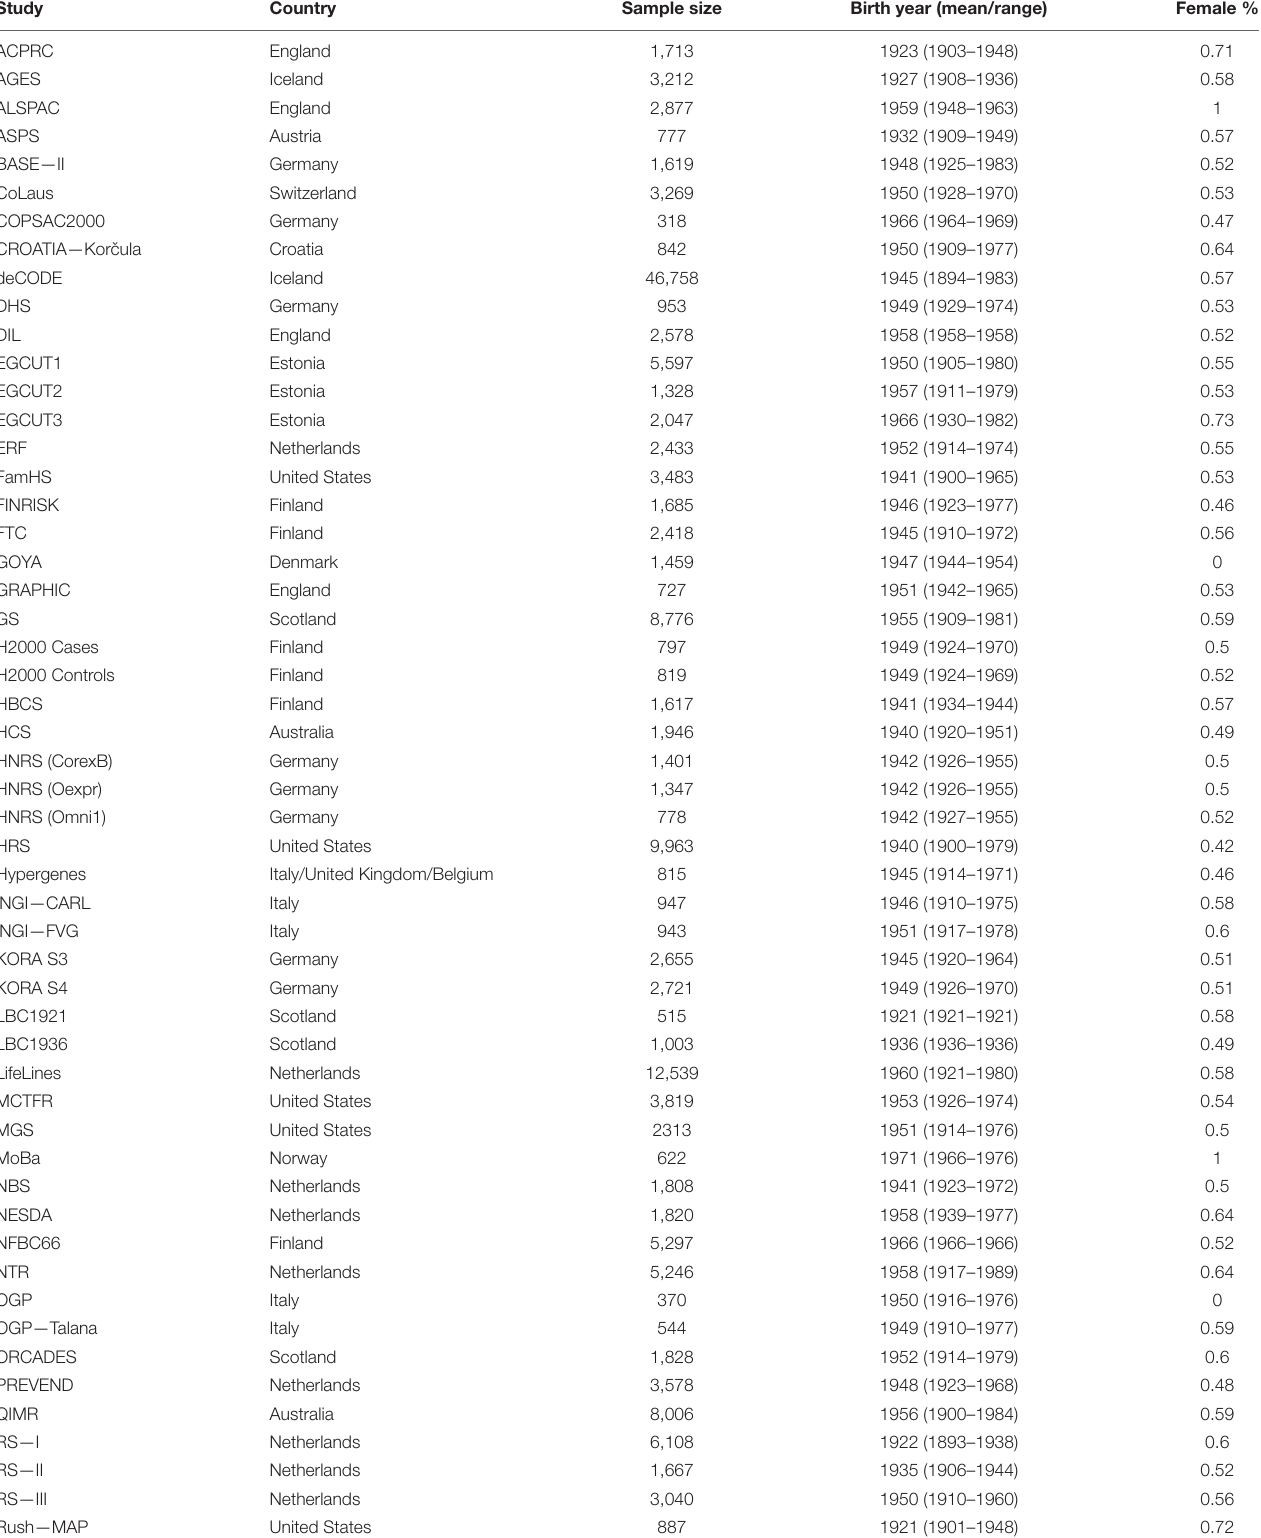
TABLE 1 | Participating cohorts in Educational attainment GWAS discovery stage (Okbay et al.,